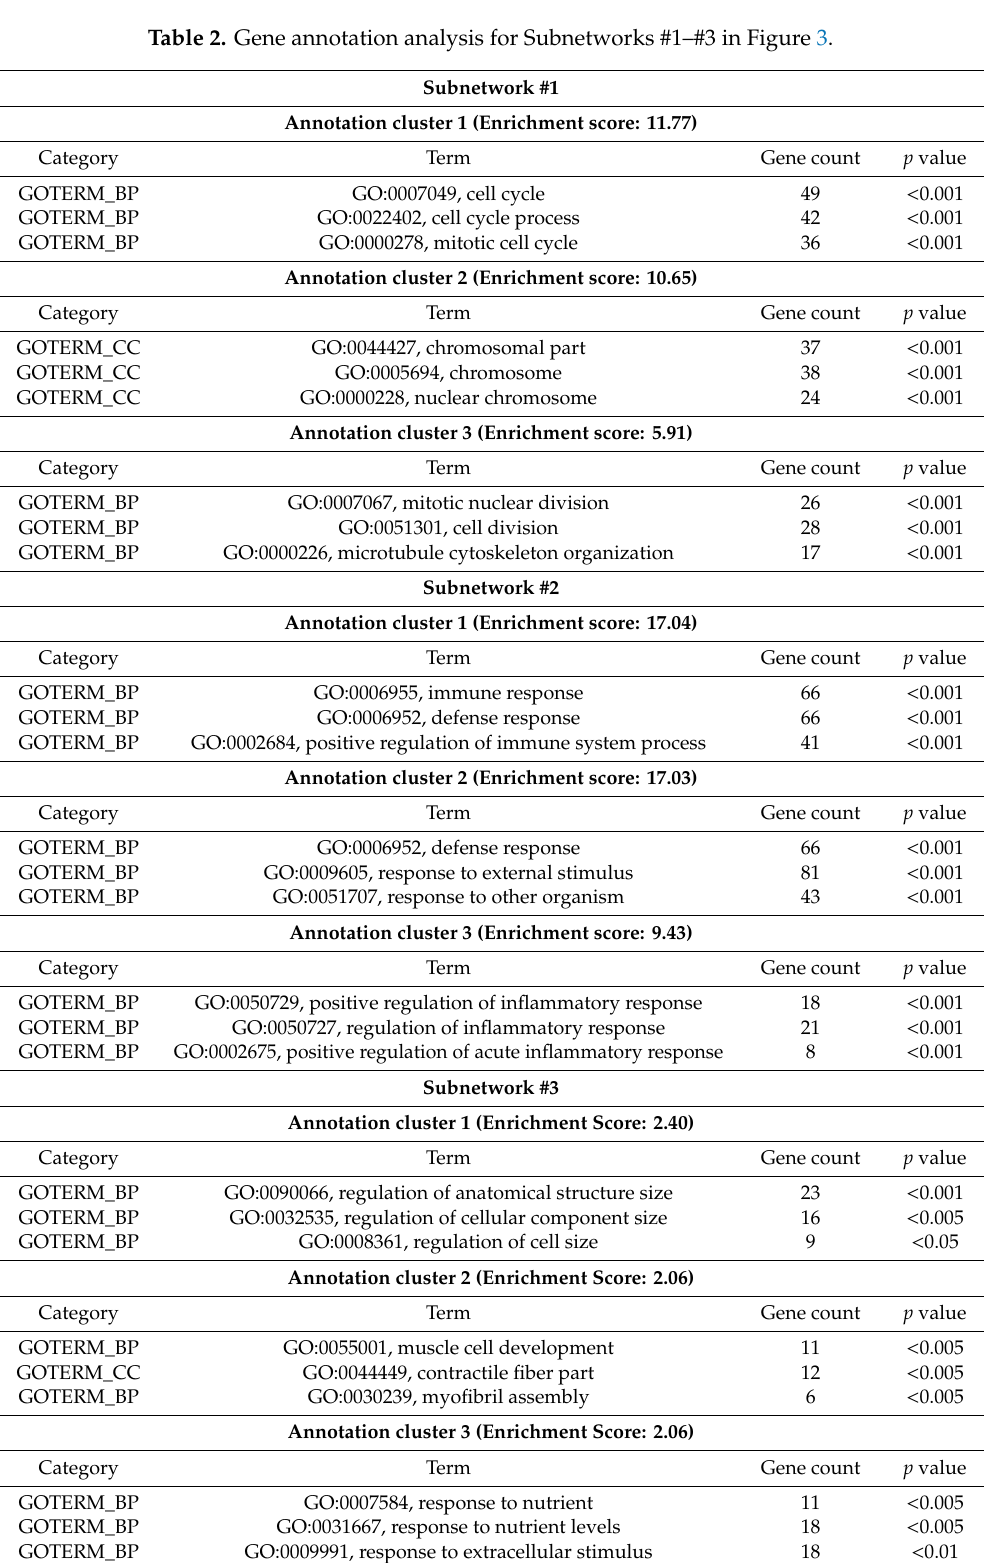
Table 2. Gene annotation analysis for Subnetworks #1–#3 in Figure